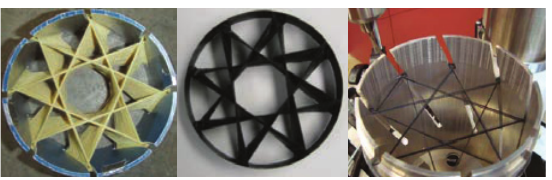
Fig.2 Rapid prototypes of wound impeller using winding machine Figure 2. Rapid prototypes of wound impeller using winding